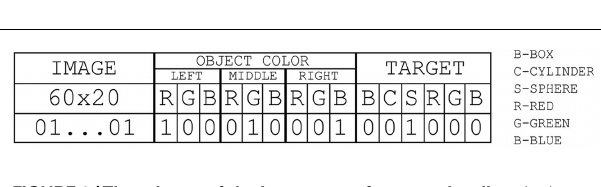
FIGURE 2 |The scheme of the proposed model in terms of neural network modules (TL, target localizer,AN, action learning,AN, action naming).